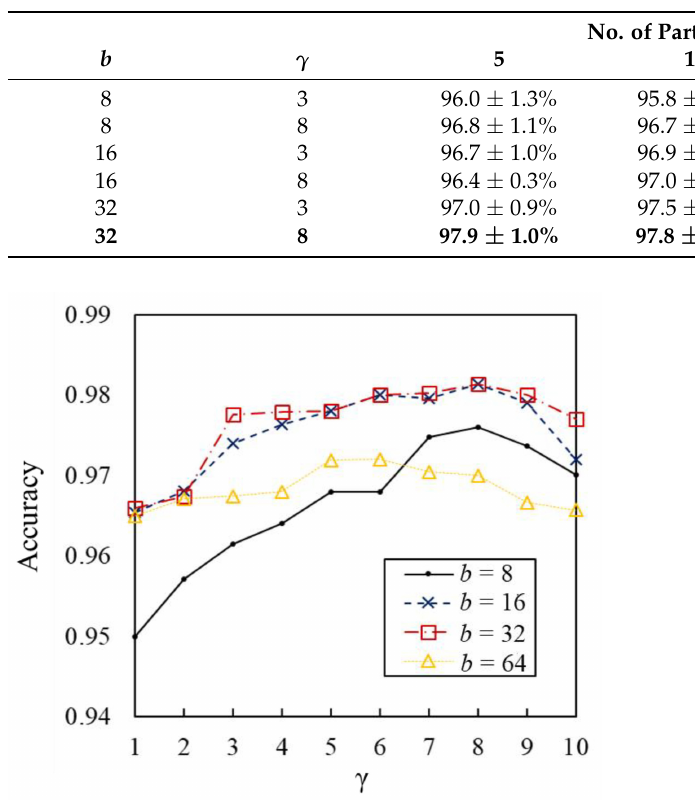
Figure 8. Identification accuracies using WT for various parameters ( N = 25).